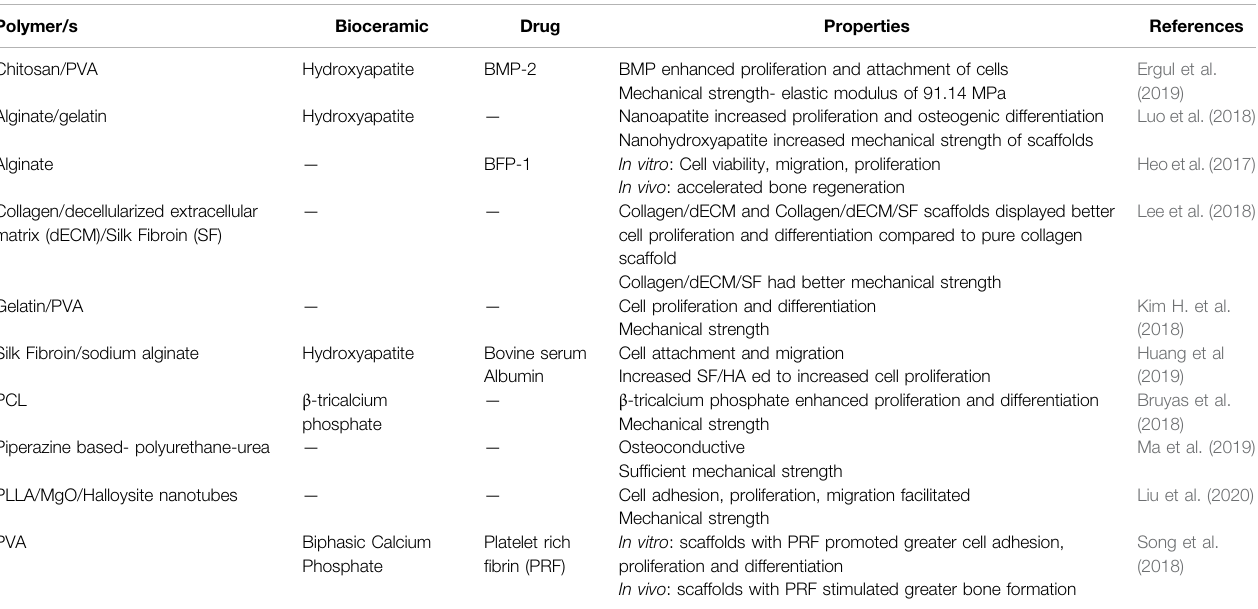
TABLE 1 | Combinations of polymers and bioceramic composite scaffolds and their properties.